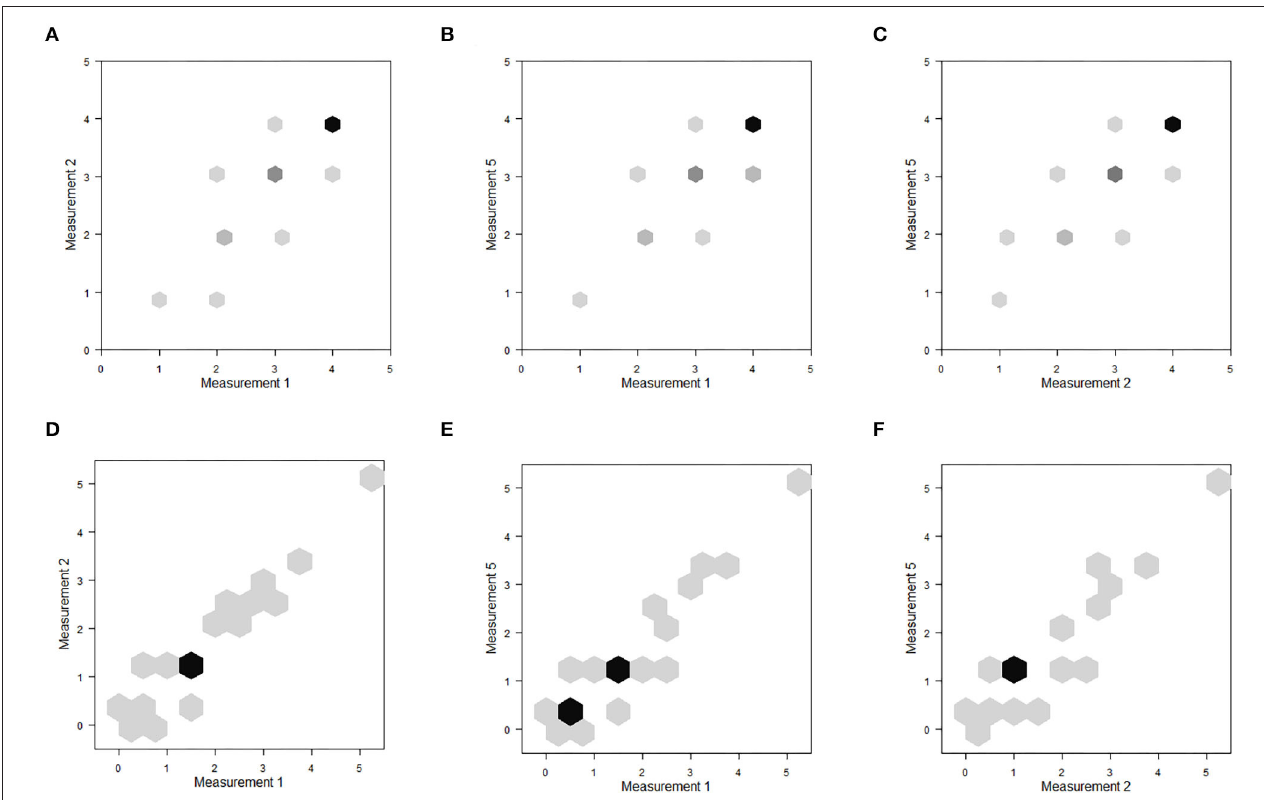
FIGURE 5 | Intra-observer reliability–Score accordance of (A,D) measurements 1 and 2; (B,E) measurements 1 and 5; (C,F) measurements 2 and 5. (A–C) show the plumage score points for each body part (132 scores); (D–F) show the fat score (22 scores). Darker points represent overlapping scores, the darker the more overlapping data